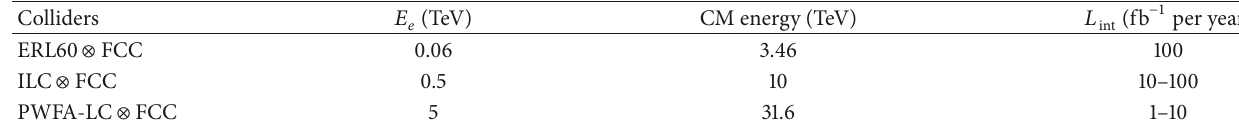
Table 1: Main parameters of the FCC-based 𝑒𝑝 colliders.